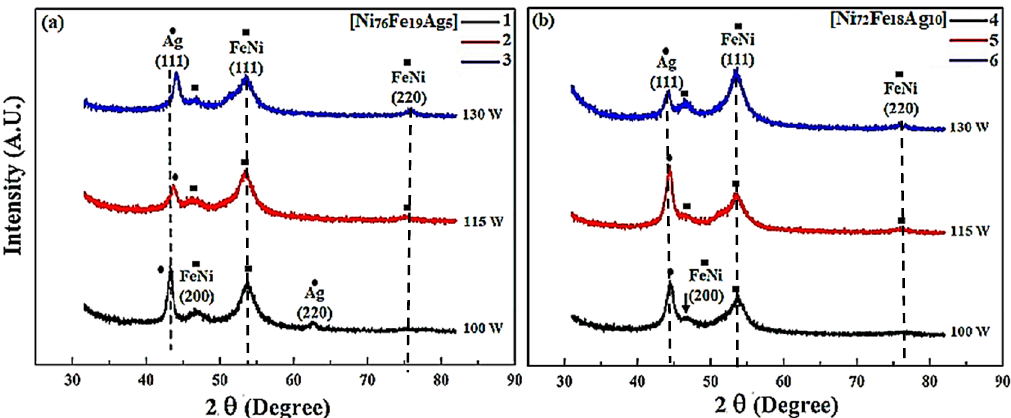
Figure 1. X-ray diffraction (XRD) pattern of thin films using different target compositions ( a ) Ni 76 Fe 19 Ag 5 ; ( b ) Ni 72 Fe 18 Ag 10 , and sputtering power (samples 1 and 4 = 100 W: 2 and 5 = 115 W: 3 and 6 = 130 W).